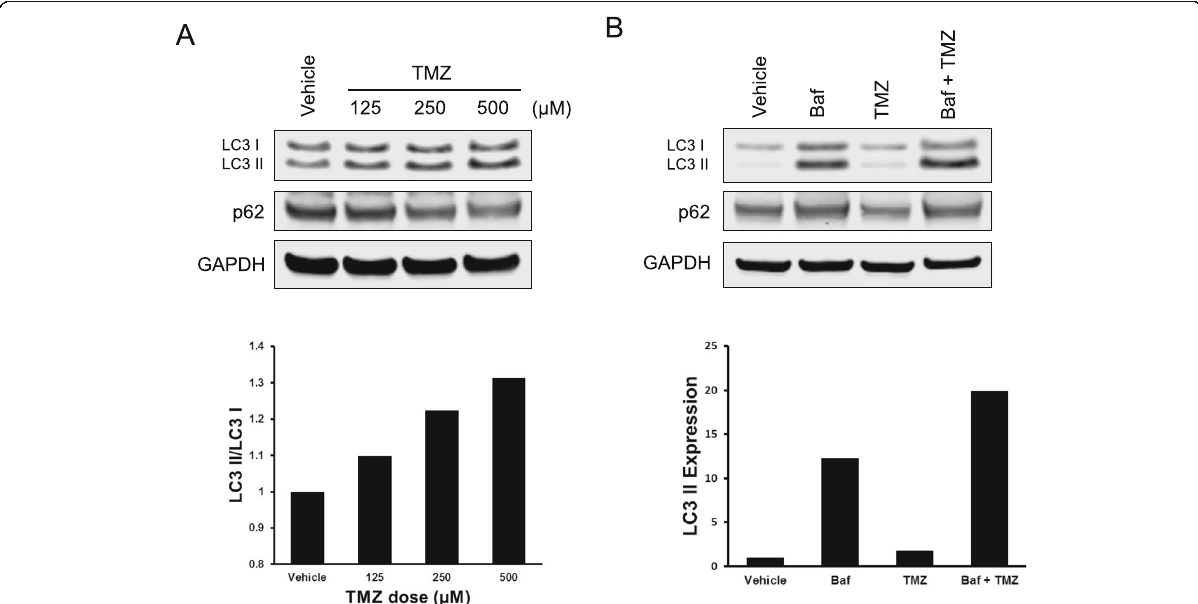
Fig. 1 Temozolomide induces autophagic flux in glioma cells. a T98G cells were treated with increasing doses of TMZ for 48 h and only living (attached) cells were collected for analysis. Western blotting shows an increase in LC3 II protein levels and a decrease in p62 protein levels. GAPDH was used as a loading control. b The LC3 flux assay was performed on T98G cells. T98G cells were treated with vehicle or TMZ (500 μ M) for 48 h containing either DMSO or Baf (10 nM) and only living (adherent) cells were collected. Western blotting for LC3 indicates an increase in LC3 II for the TMZ + Baf lane compared to Baf alone, proving TMZ-induced autophagosome formation. The data (LC3 II/GAPDH) was quantified and graphed to mark this increase. Data represents three independent